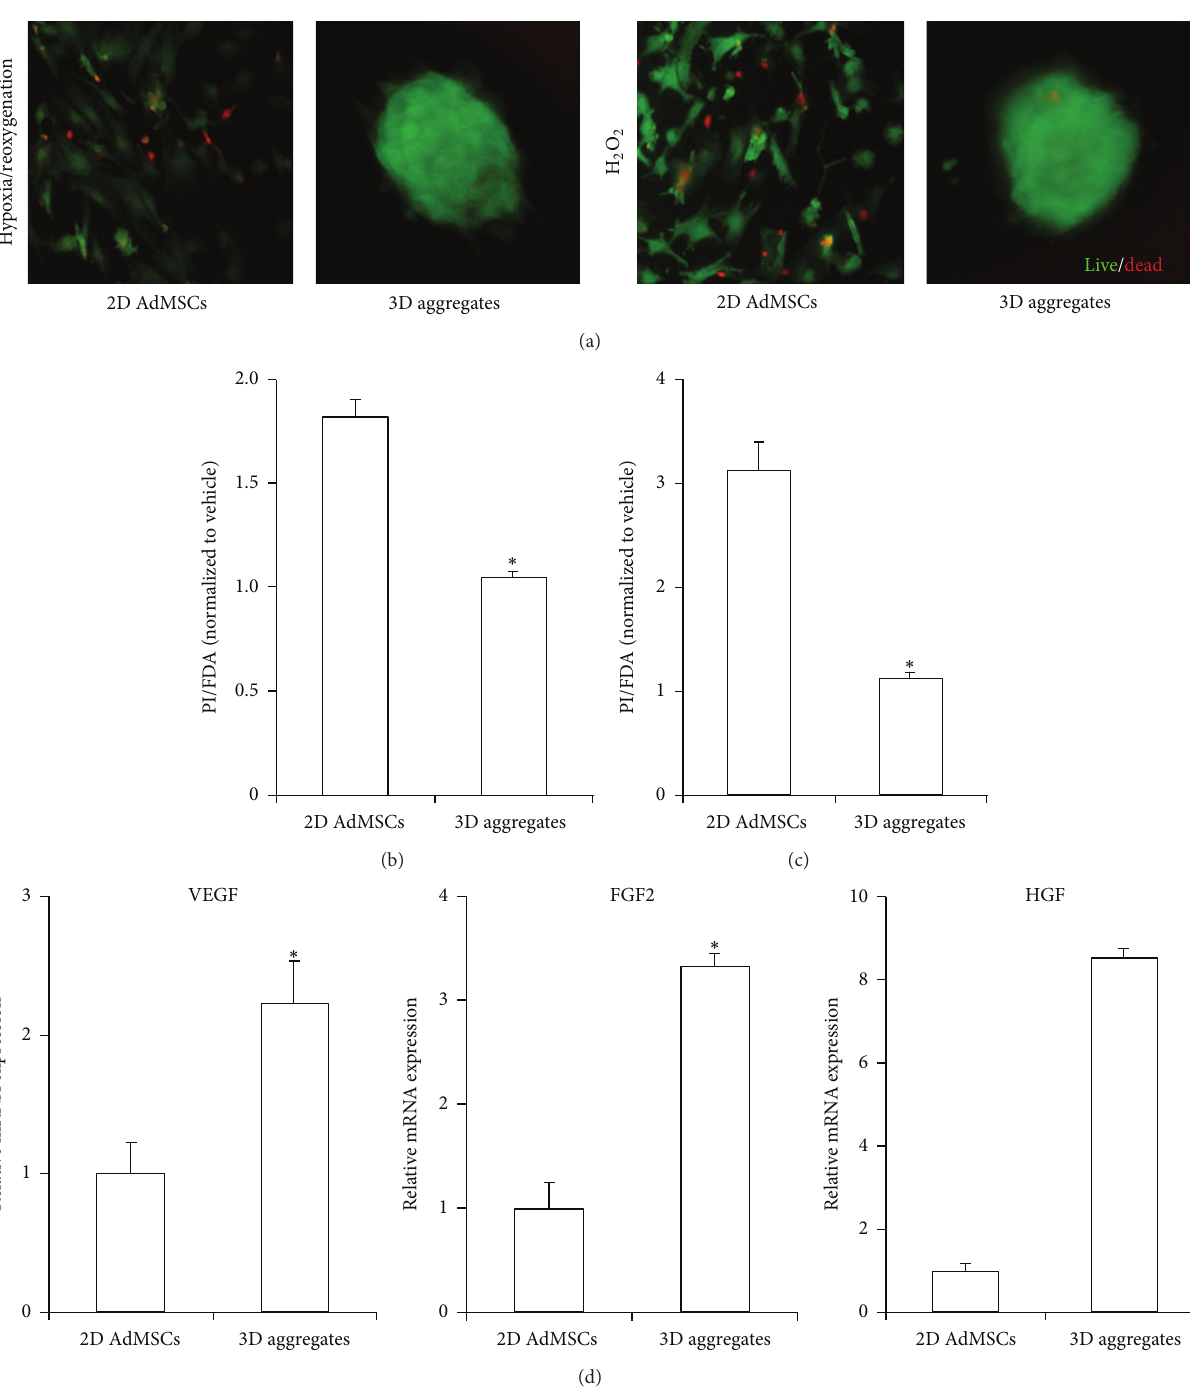
Figure 3: 3D aggregates decrease the susceptibility of AdMSCs to stress and enhance the expression of proangiogenic factors in AdMSCs. (a) Representative FDA/PI stained images of 2D AdMSCs or 3D aggregates subjected to hypoxia/reoxygenation or 200 𝜇 M-H 2 O 2 treatment. (b) Quantification of dead cells in 2D AdMSCs or 3D aggregates subjected to hypoxia/reoxygenation treatment using PI/FDA ratio. Data were normalized to the vehicle group of 2D monolayer culture. (c) Quantification of dead cells in 2D AdMSCs or 3D aggregates subjected to 200 𝜇 M-H 2 O 2 treatment using PI/FDA ratio. Data were normalized to the vehicle group of 2D monolayer culture. (d) Relative mRNA expression of VEGF, FGF2, and HGF in 2D AdMSCs and 3D aggregates. ∗ 𝑃 < 0.05 compared with 2D